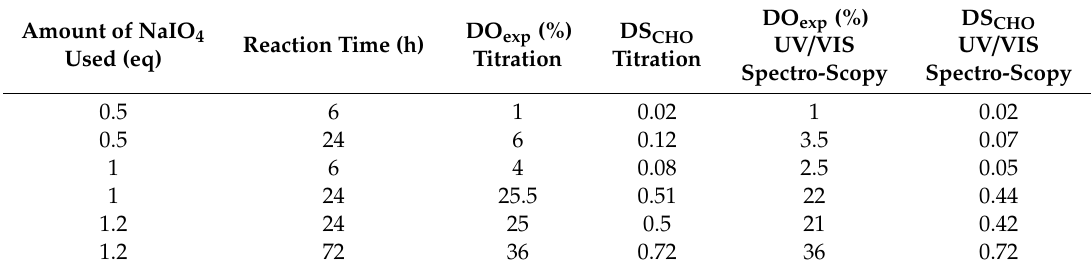
Table 2. Reaction conditions for oxidation of native hyaluronic acid with the corresponding degrees of oxidation and